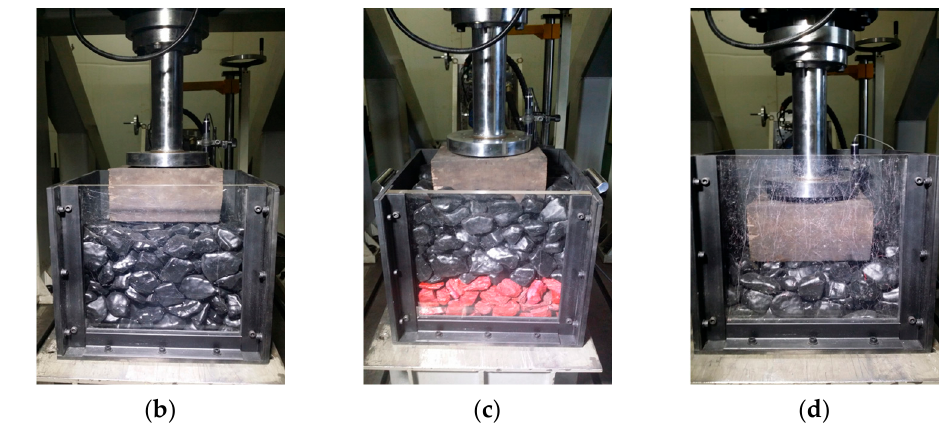
Figure 4. View of tests in each laboratory experiment: ( a ) normal ballast (300 mm), ( b ) coated ballast (250 mm), ( c ) normal ballast (150 mm) and coated ballast (150 mm), ( d ) coated ballast (100 mm).